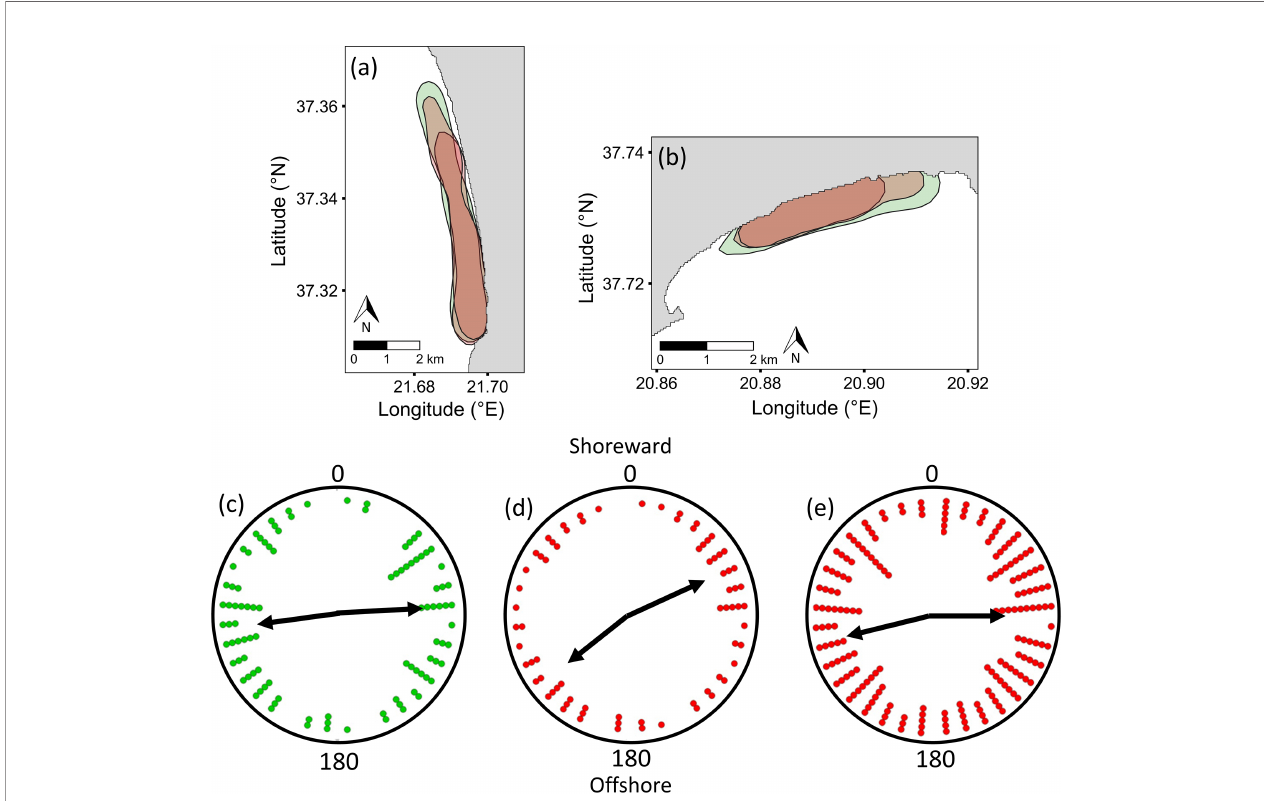
FIGURE 4 | Variability in the 50% Kernel Utilisation Distribution (KUD) of male (May and June surveys combined: green fi ll) and female (May: larger red fi ll; June: smaller red fi ll) loggerhead sea turtles at (A) Kyparissiakos and (B) Zakynthos. For solitary turtles at both sites (data were combined as the same bimodal trends were detected), (C) males were oriented parallel to shore in May (left-right or right-left), whereas (D) females were oriented diagonally to shore in May and (E) parallel, but with high variability, in June. Data are presented in 10-degree bins; circular means for each mode are shown as black arrows. Female count values for each bin were divided by 7 to allow comparison with male